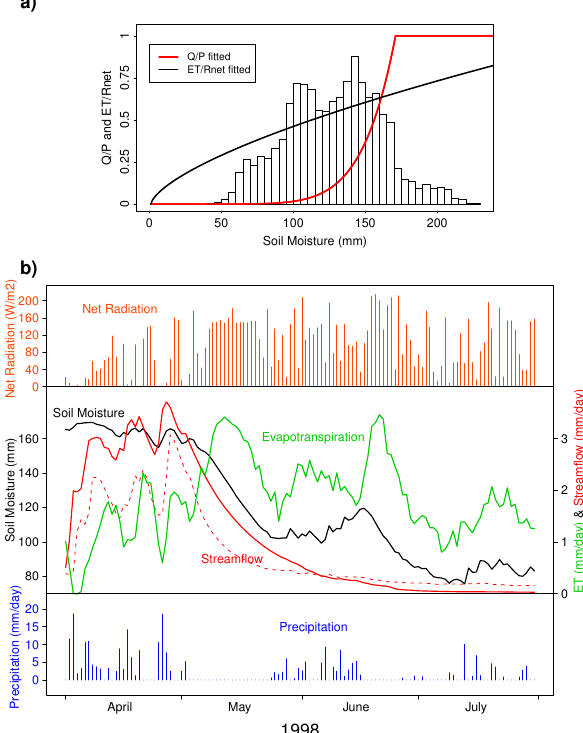
Figure 4: a) Fitted normalized runoff (Equation (2)) and ET (Equation (3)) functions for the Le Saulx catchment in eastern France (indicated by an arrow in Figure 1). The background histogram shows the relative abundance of soil moisture contents between April and October. b) Time series of forcing (net radiation at the top, precipitation at the bottom) and according output of the simple model (soil moisture, streamflow and ET in between the forcings) from the Le Saulx catchment during a pronounced dry-out period from April until July 1998. The dashed red line indicates the evolution of the observed streamflow. The fitted water holding capacity for this catchment is 170 mm, such that the normalized streamflow function reaches 1 at this soil moisture content. Note that the ET time series has been smoothed to facilitate the readability of the graph such that each value represents the average of the current day, the three preceding days and the three following days.